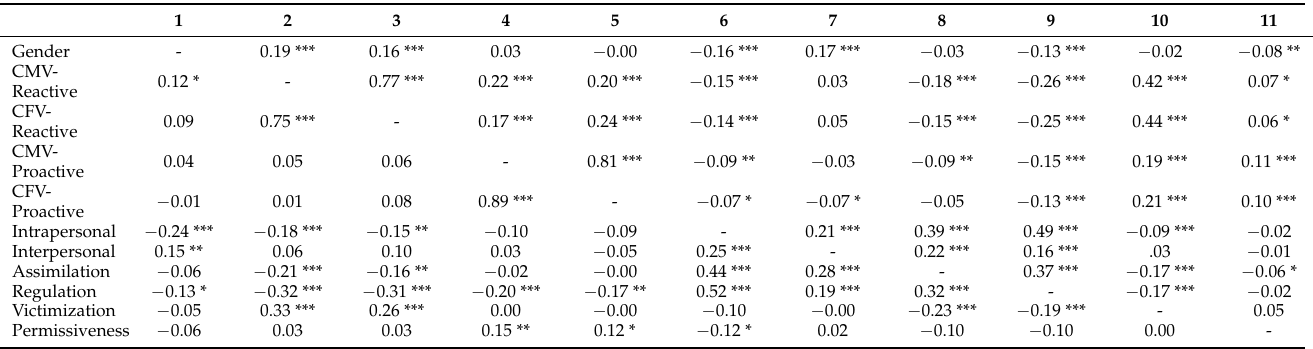
Table 3. Inter-correlations between the study variables.